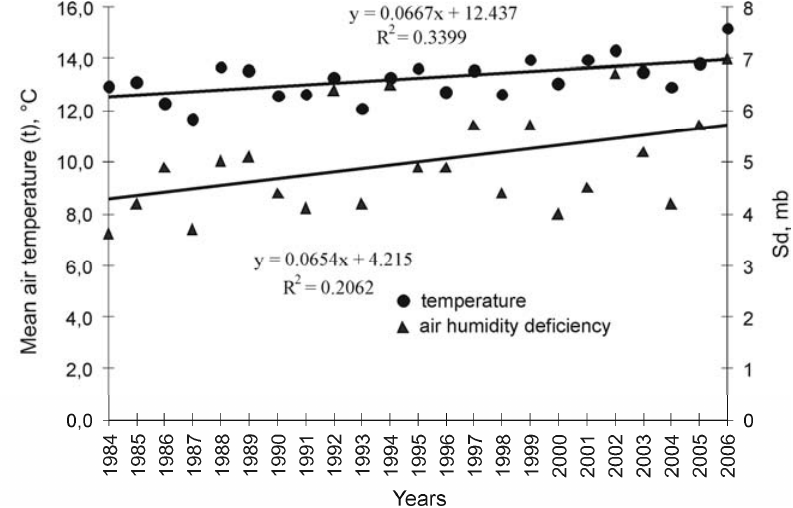
Fig. 5. Variation in mean air temperature and mean daily moisture deficiency (Sd) during the period of active